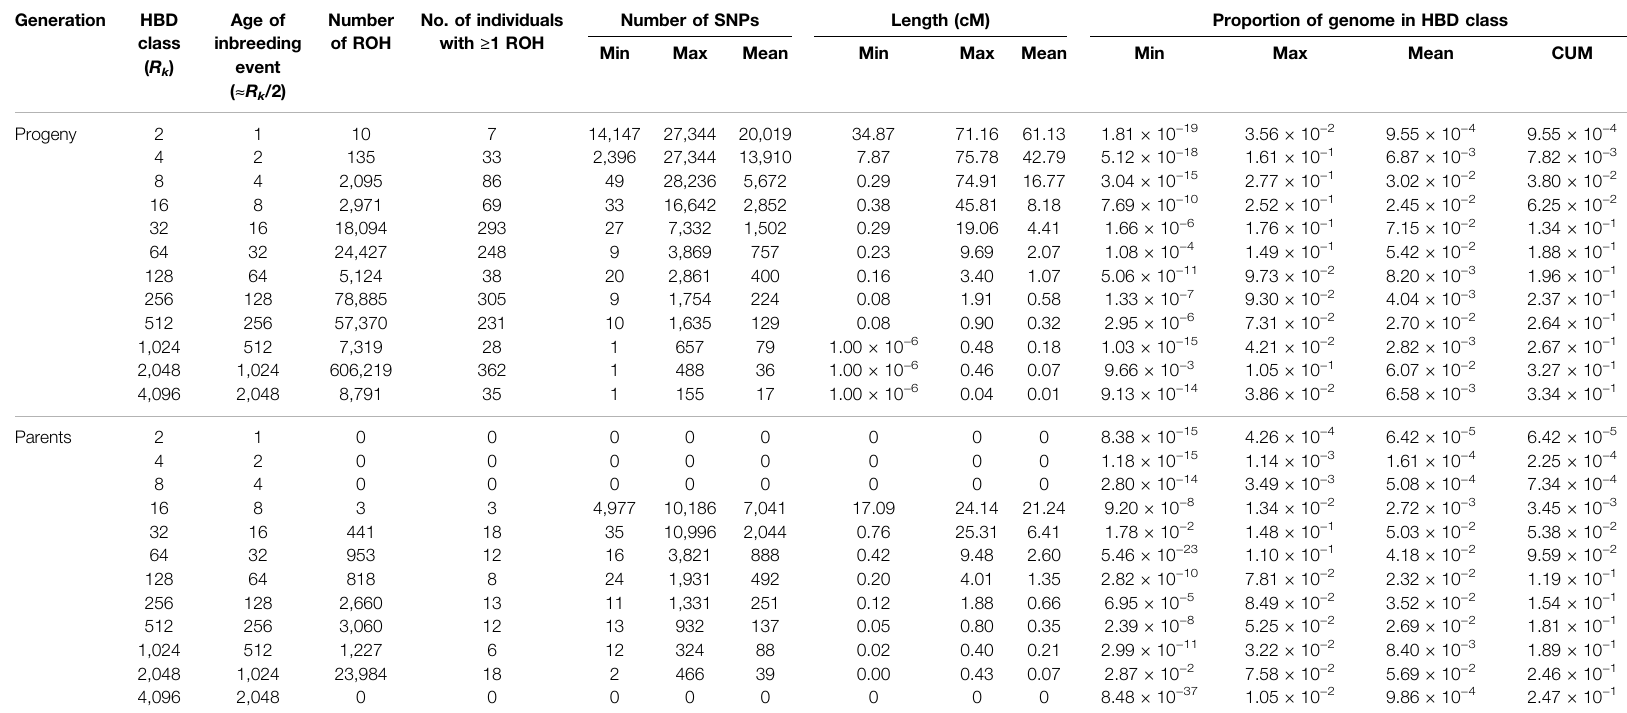
TABLE 2| Descriptive statistics ofrunsofhomozygosity (ROH) and autozygosity contributions forthedifferentage-related homozygous-by-descent(HBD)classes withpre-de fi ned ratesofancestry change( R k )forprogeny and parents. cM, centiMorgan; CUM, cumulative autozygosity.